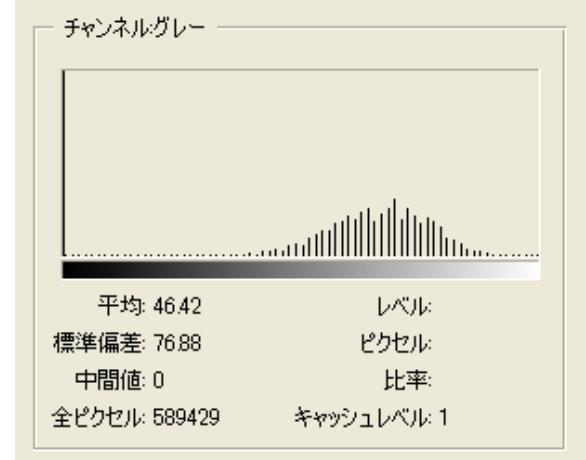
Figure 5 Histogram of urban area.